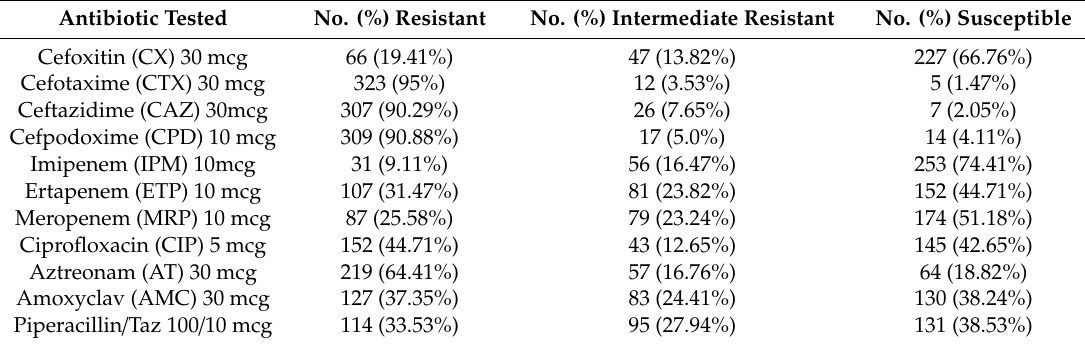
Table 2. Antibiotic susceptibility profiles of ESBL + E. coli (n = 340) isolated in this study.